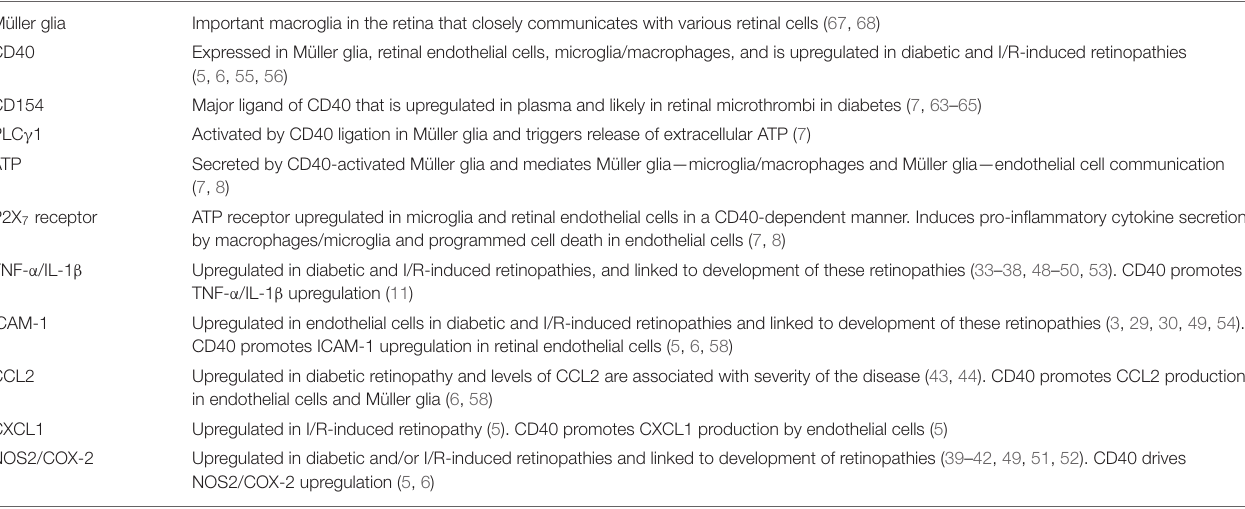
TABLE 1 | Components of the CD40-ATP-P2X 7 pathway in retinopathies. Müller